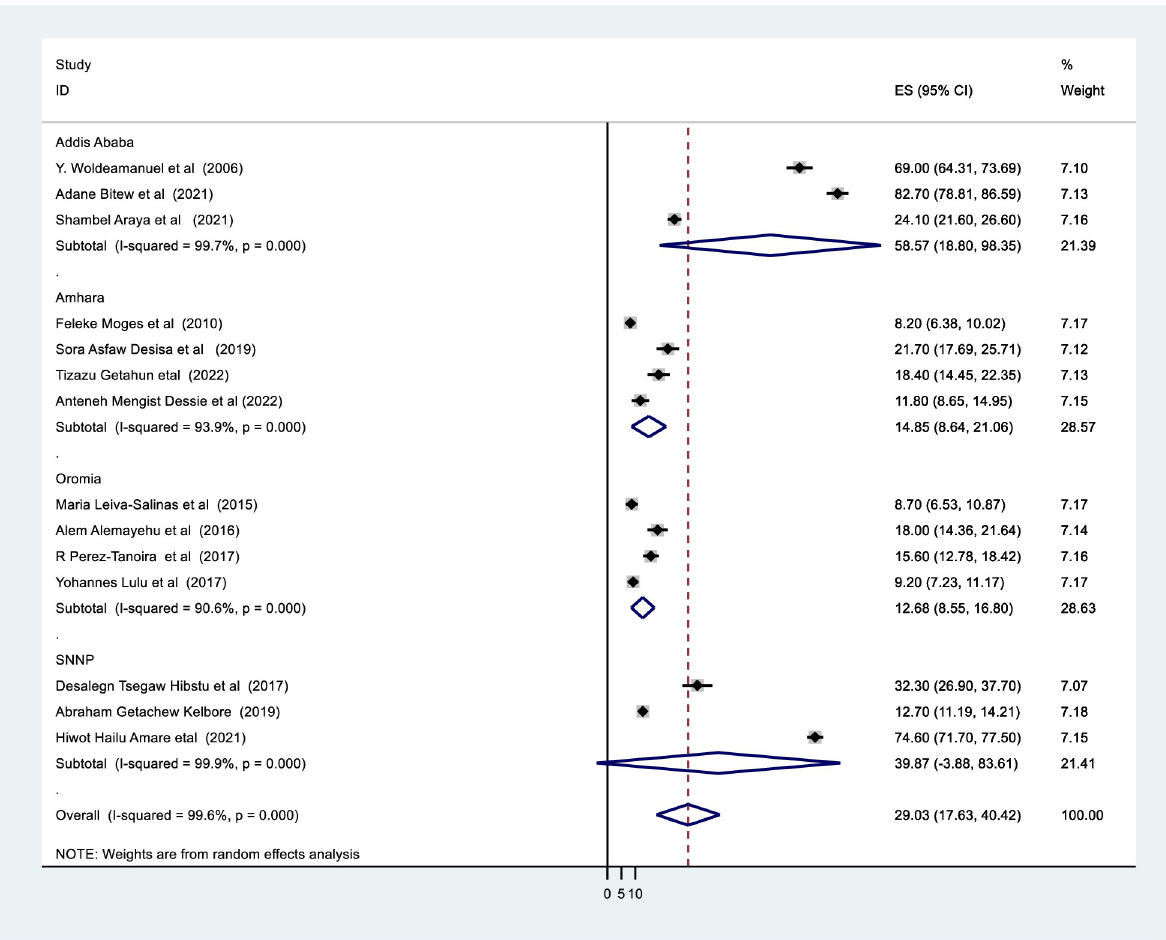
Fig 3. Subgroup meta analysis of tinea capitis using study setting in